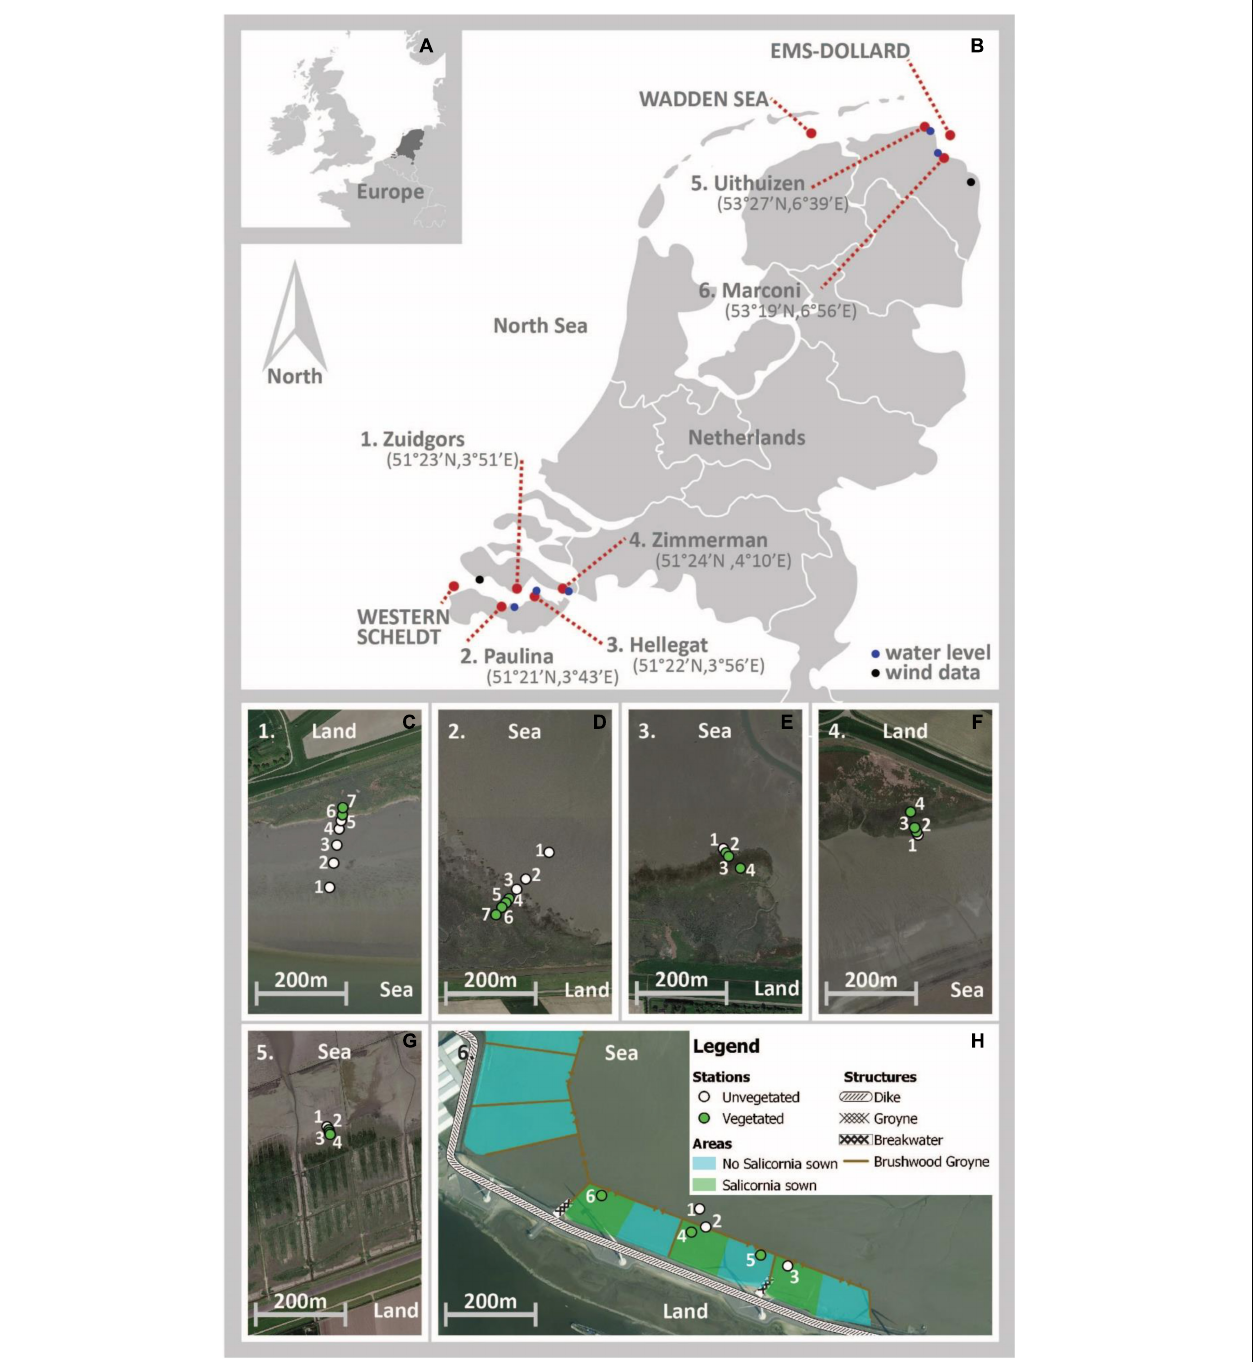
FIGURE 1 | Study sites around the North Sea area (A) indicated with a red dot (B) . Locations where water levels were continuously monitored are indicated with a blue dot and the location were wind data were collected is indicated with a black dot (B) . The measurement stations (numbered) for bed level dynamics are marked with green (vegetated) and white (unvegetated) dots for each of the study sites (C–H) . Source of background maps (C–G) is Google Maps, source of background map (H) is MapTiler and OpenStreetMap contributors.